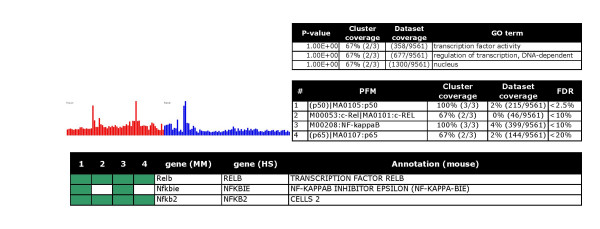
NF-kappaB pathway: Over representation of REL and NFkappaB motifs indicates feed back signalling. Tables and charts are organized as in figure 2.